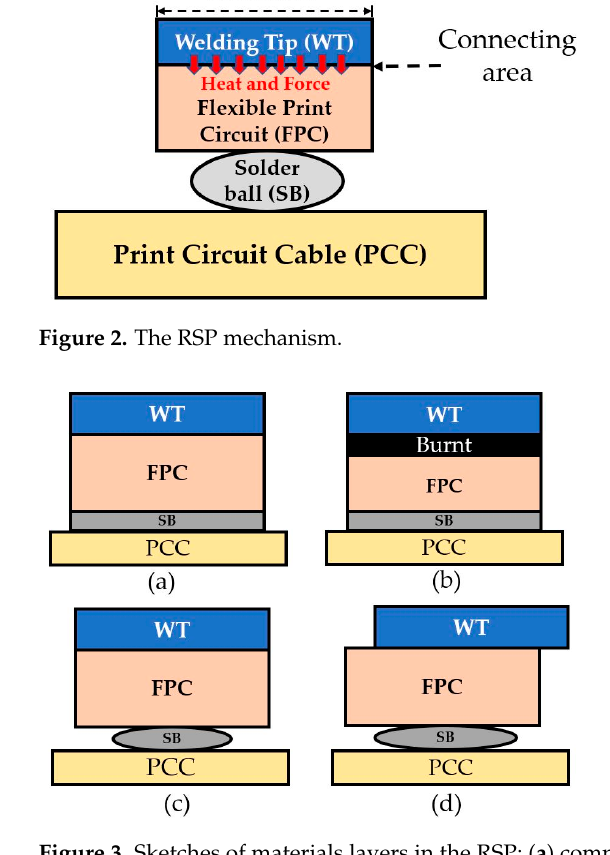
Figure 3. Sketches of materials layers in the RSP: ( a ) complete, ( b ) burnt defect, ( c ) incomplete melt defect, and ( d ) misaligned defect.